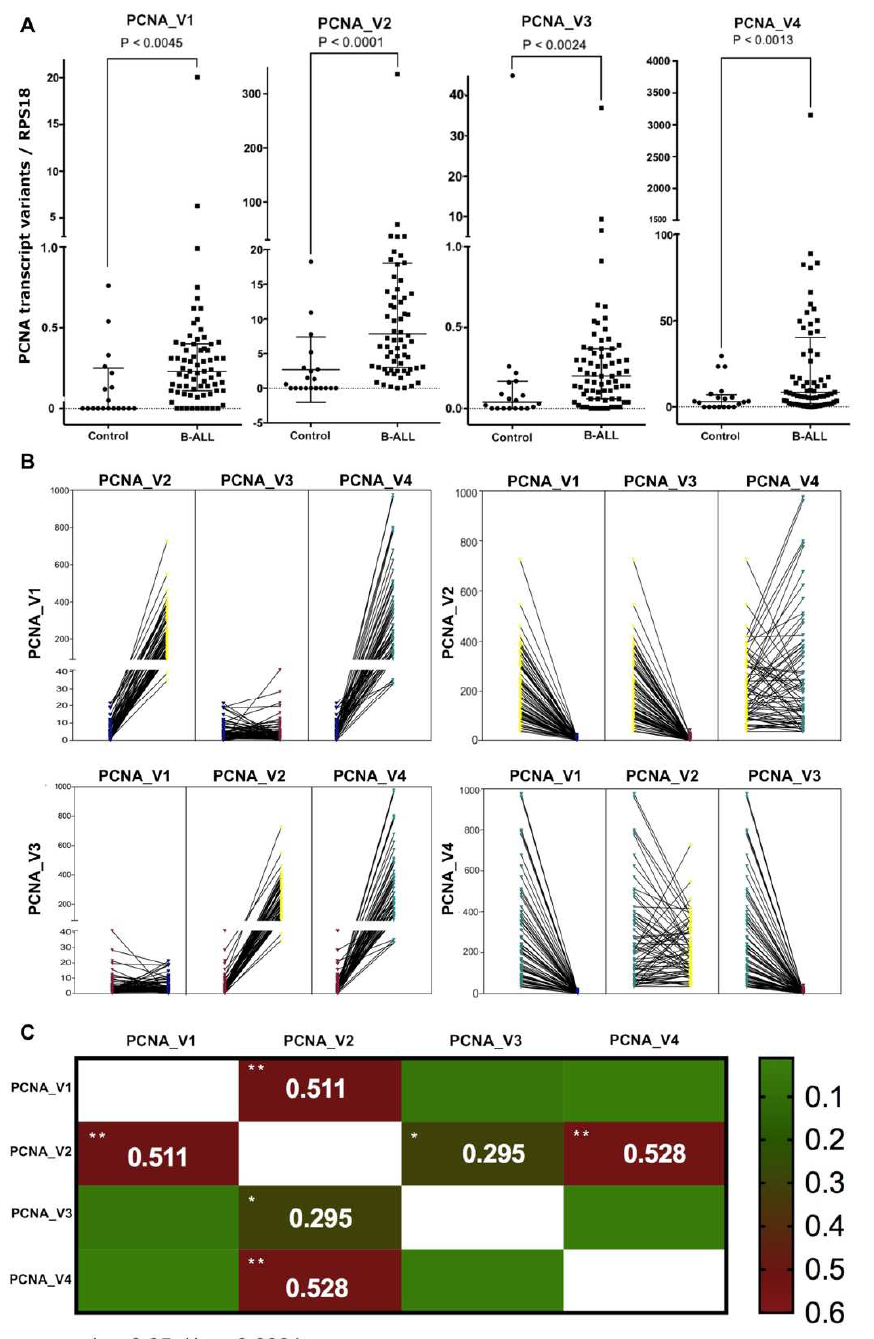
Figure 8. Expression of PCNA transcript variants in B-cell ALL patients. We performed absolute quantification using digital droplet RT-PCR. The y -axis shows the mRNA copy number of the PCNA transcript variants. The x -axis shows the healthy peripheral blood controls and B-ALL patients. ( A ) We observed significant overexpression of the PCNA transcript variants in B-LL patients. The four transcripts showed different levels of expression; the least expressed was PCNA_V1, followed by PCNA_V3 and PCNA_V2, and the most expressed was PCNA_V4 (Mann-Whitney U test). ( B ) The plot shows the comparison of the expression levels of the four PCNA transcript variants in all B-ALL patients analyzed (Mann-Whitney U test). ( C ) The heatmap shows Pearson’s correlation. Our results showed a significant correlation between PCNA_V1 and PCNA_V2, PCNA_V2 and PCNA_V3, and PCNA_V2 and PCNA_V4.